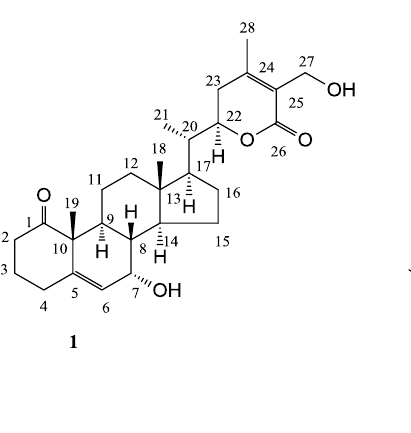
Figure 1. Structures of compounds 1 – 5